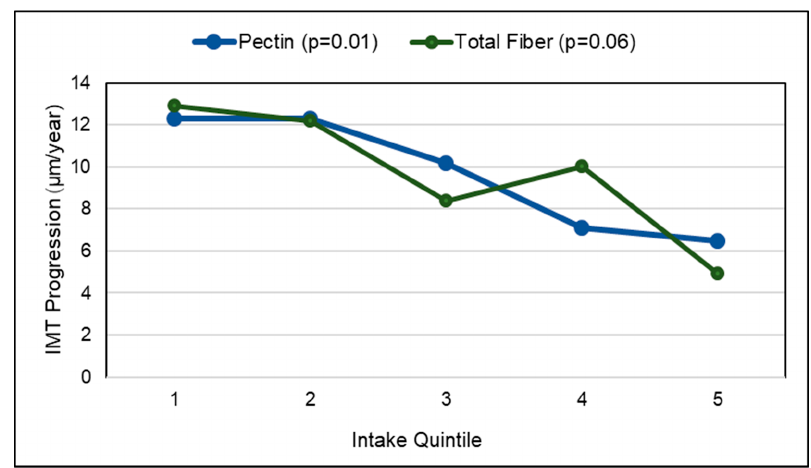
Figure 9. Progression of intima-media thickness (IMT) in the common carotid-artery by quintile of fiber intake among 500 participants in the Los Angeles Atherosclerosis Study [157].